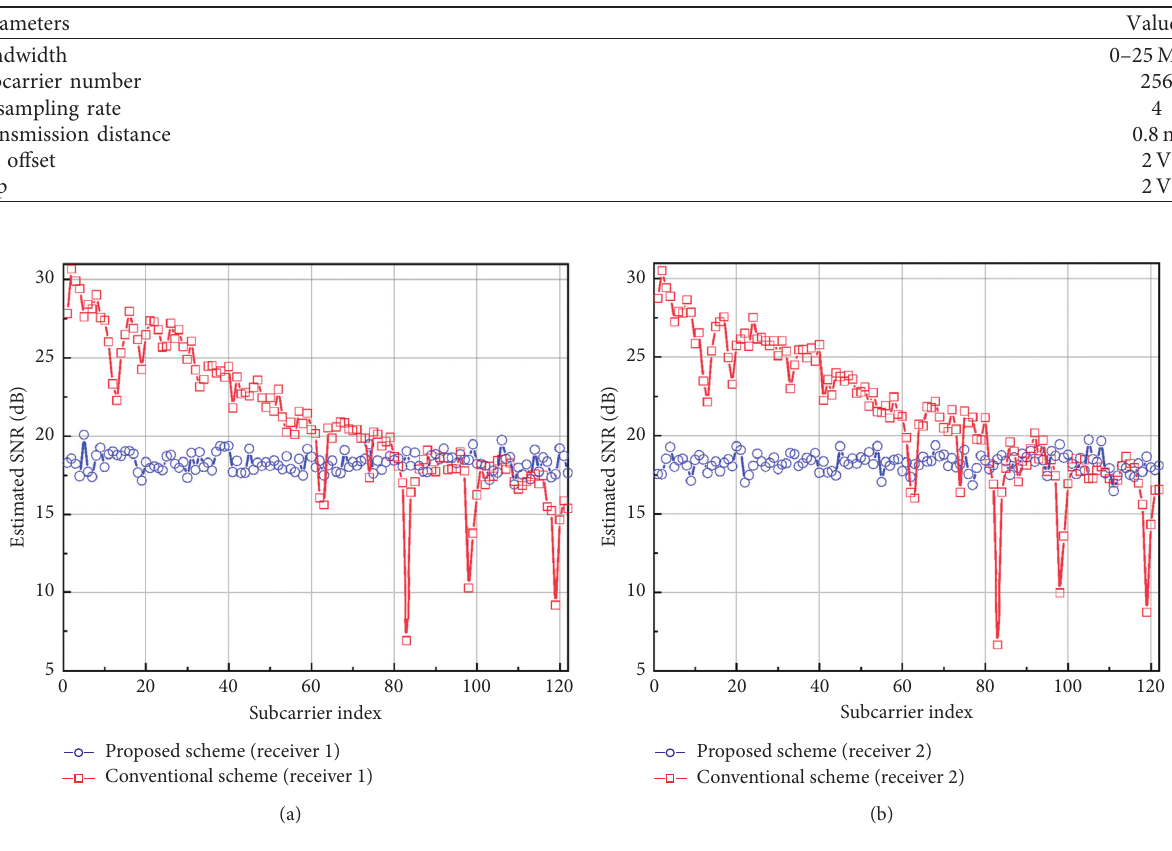
Figure 1: Experimental setup of the proposed MIMO-OFDM VLC system. Table 1: System parameters.